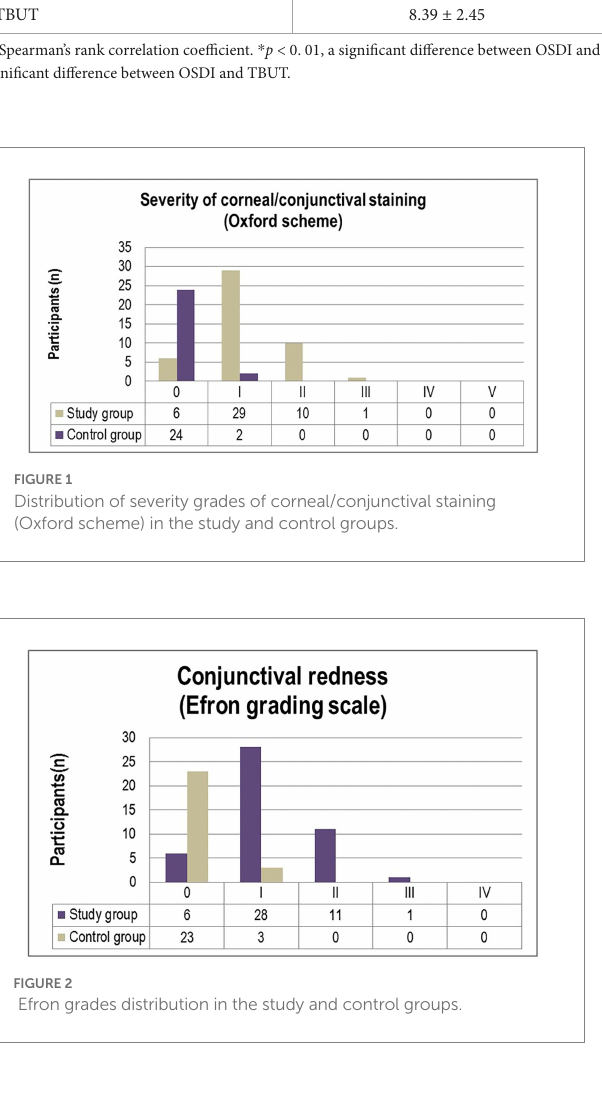
I abnormal corneal/conjunctival staining (Figure 1). Pathological patterns associated with conjunctival redness were absent in 88.5% of the control group and 13% of the experimental group ( p = 0.0001). Twenty-eight T2DM patients (61%) and three control individuals (11.5%) were diagnosed with grade I severity (mild redness of bulbar conjunctiva,